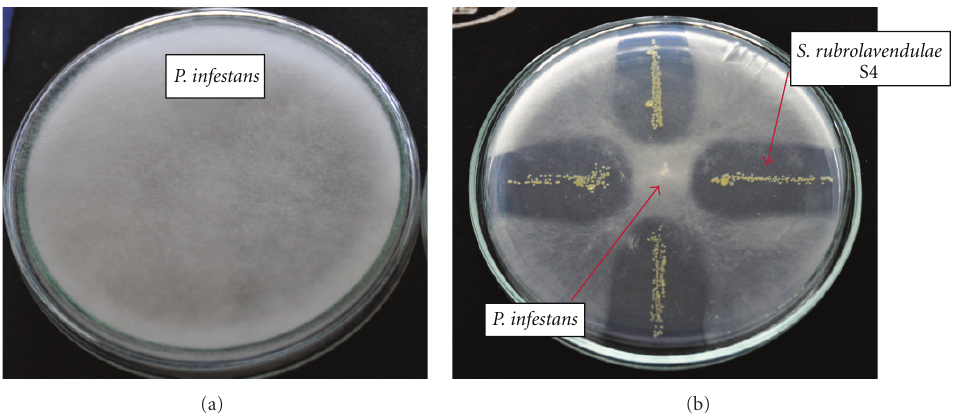
Figure 3: In vitro interactions between S. rubrolavendulae S4 and Phytophthora infestans on V8 medium. (a) Control plate of Phytophthora infestans ; (b) S. rubrolavendulae S4 against Phytophthora infestans